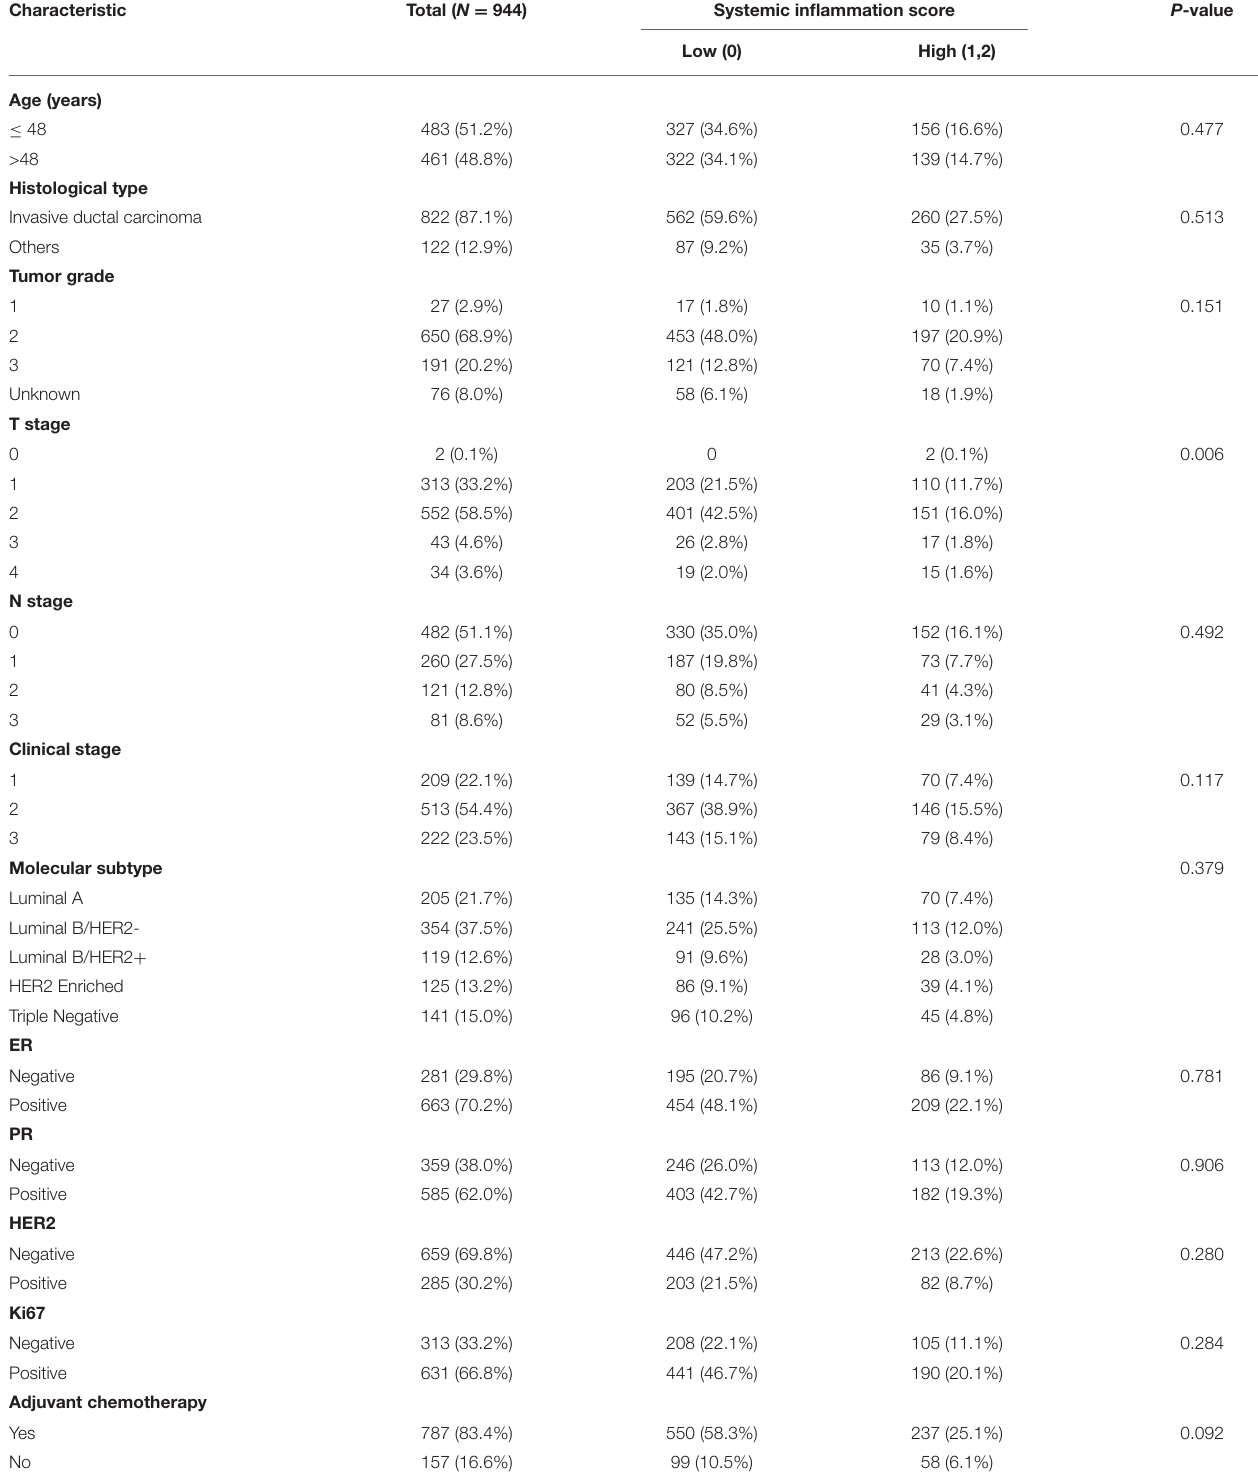
TABLE 2 | The relationship between SIS group and clinicopathological characteristics in the training set.